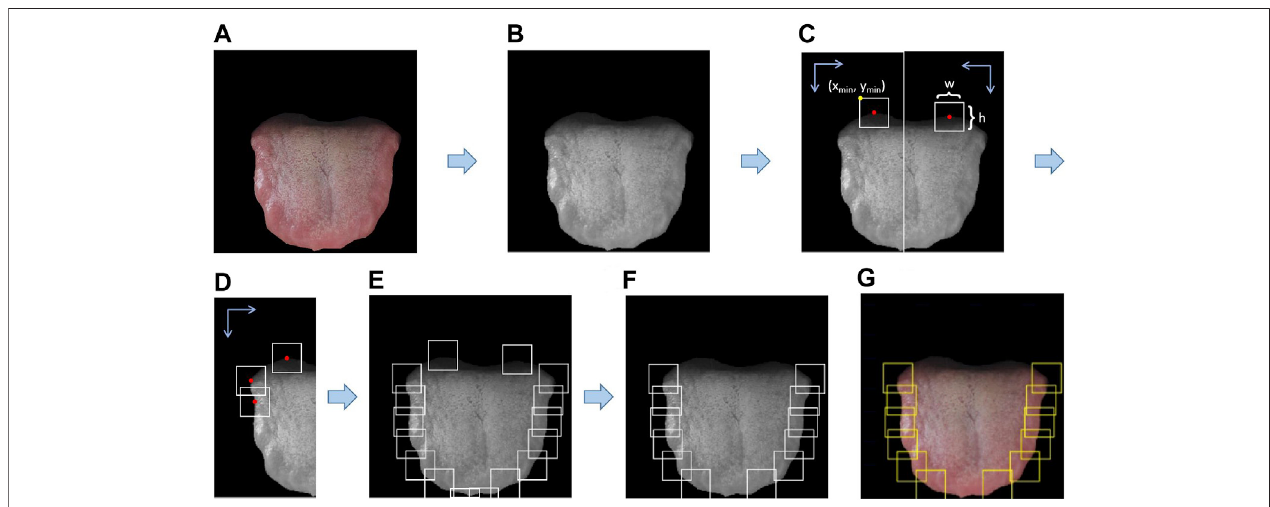
FIGURE6| Candidateregiongenerationmethodbasedonlocationinformation.Thearrowindicatesthetraversaldirection.Taketheleftasanexample,fromtopto bottom, from left to right, and the right side isthe same symmetrical operation. The red point isthe fi rst non-zero value point traversed, asthe midpoint ofthe tooth mark candidate area, (x min , y min ) is the upper left corner of the tooth mark candidate area, h and w represent the tooth mark candidate area respectively height and width.